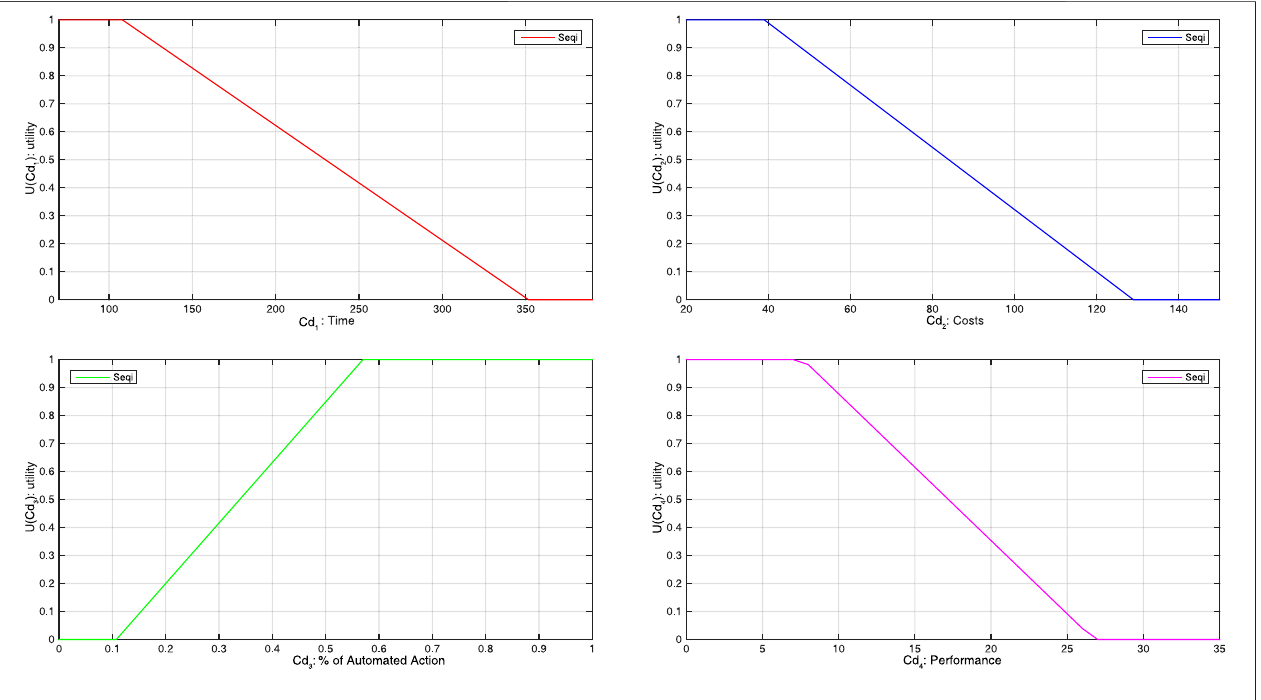
FIGURE 9 | Utility